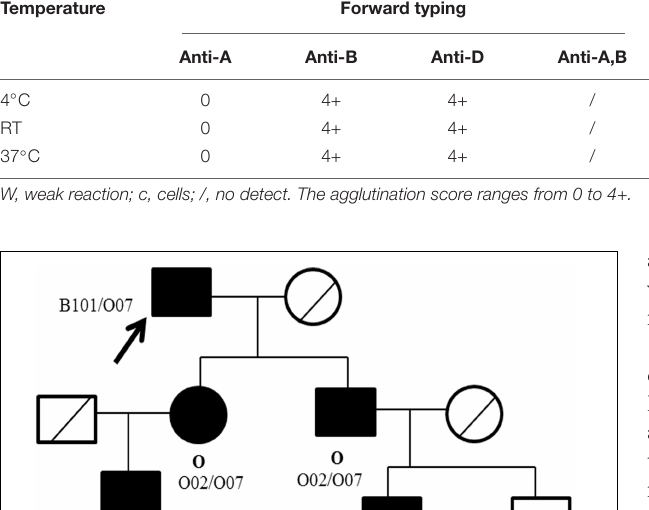
• (cid:4) Carriers with O07